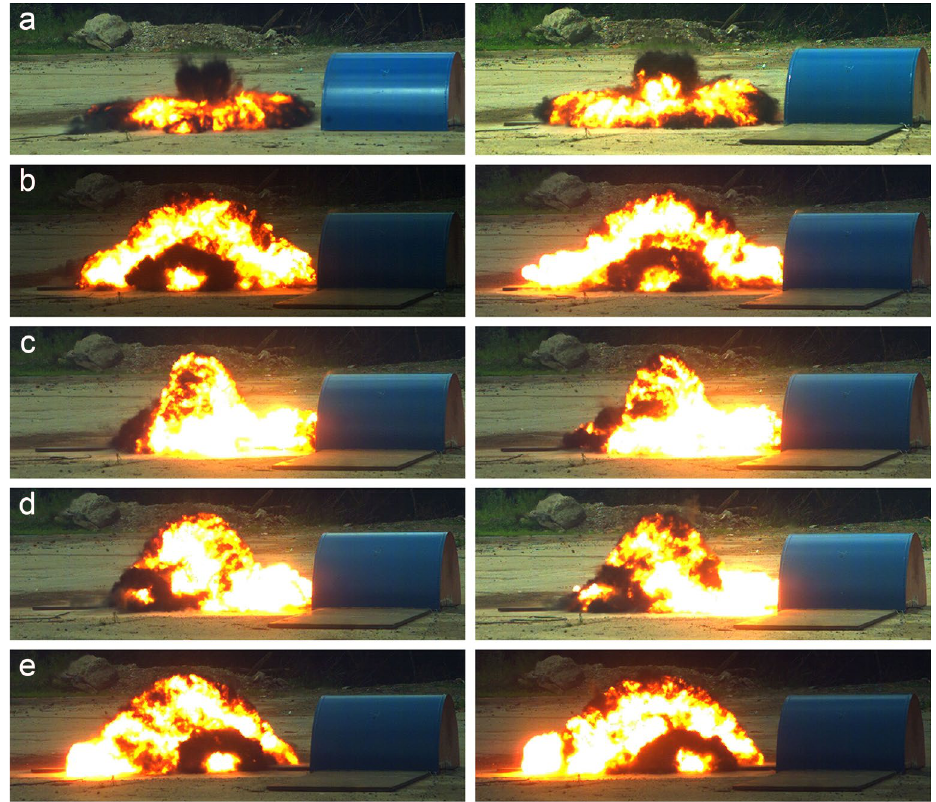
Figure 4. Detonation products of repeated tests at 2 ms. ( a ) Case 1. ( b ) Case 2. ( c ) Case 3. ( d ) Case 4. ( e ) Case